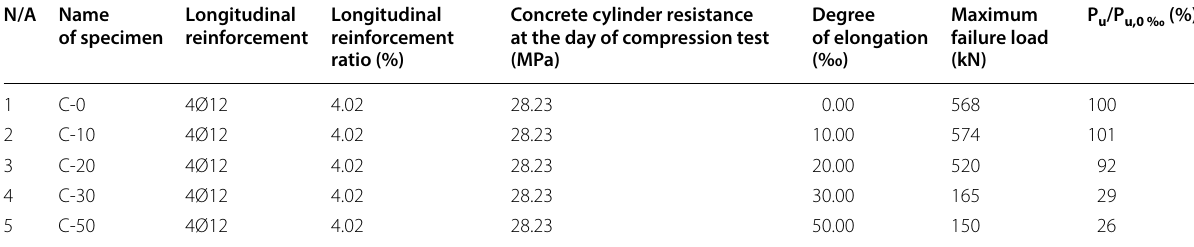
Table 4 Maximum failure load during the compression test.